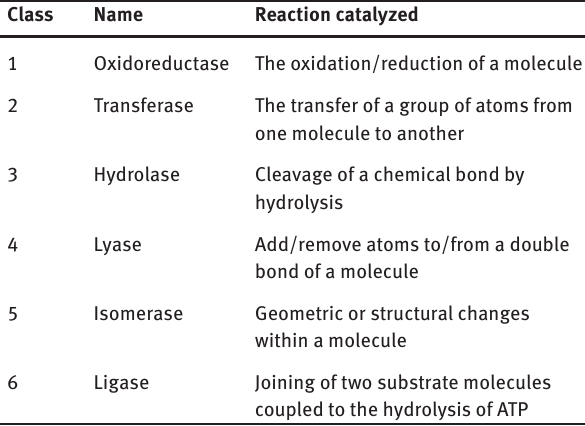
Table 1: Class of enzymes according to the Enzyme Commission (EC) number and the reaction